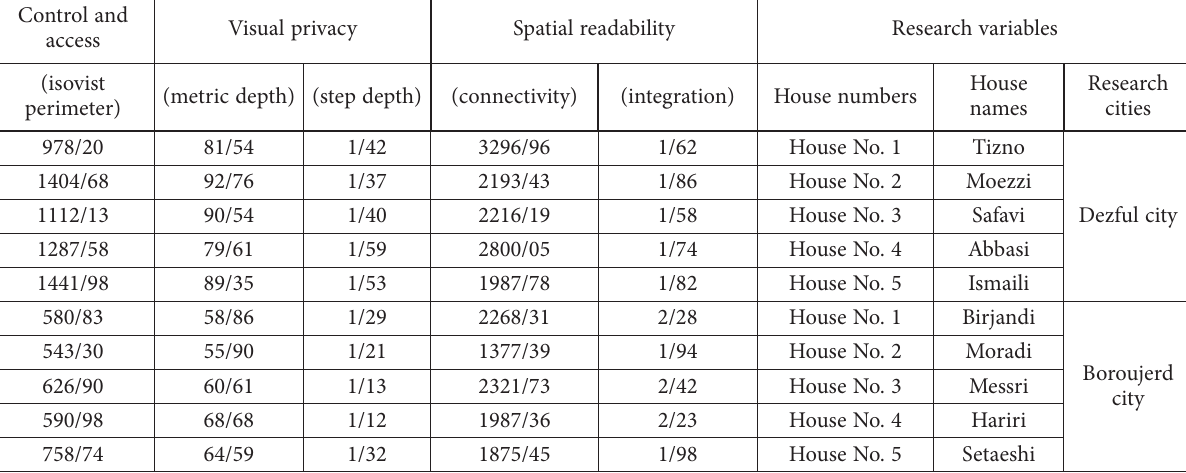
Table 5. Quantitative and numerical analysis of the spatial configuration of research houses (source: compiled by the